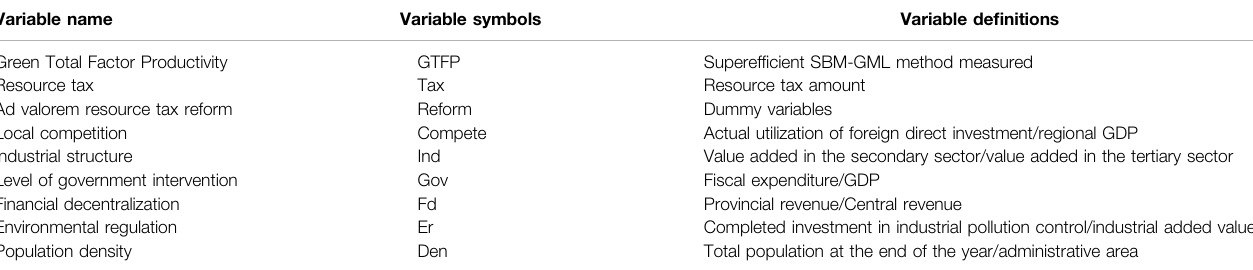
TABLE 4 | De fi nition of variables. Variable